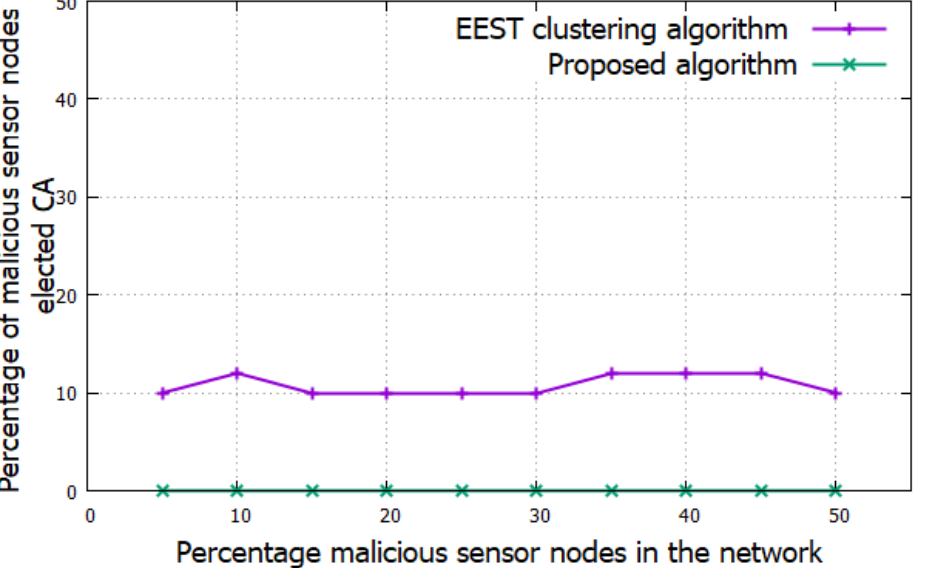
Figure 5. The percentage of malicious sensor nodes elected CA as a function of the total number of malicious sensor nodes in the network.